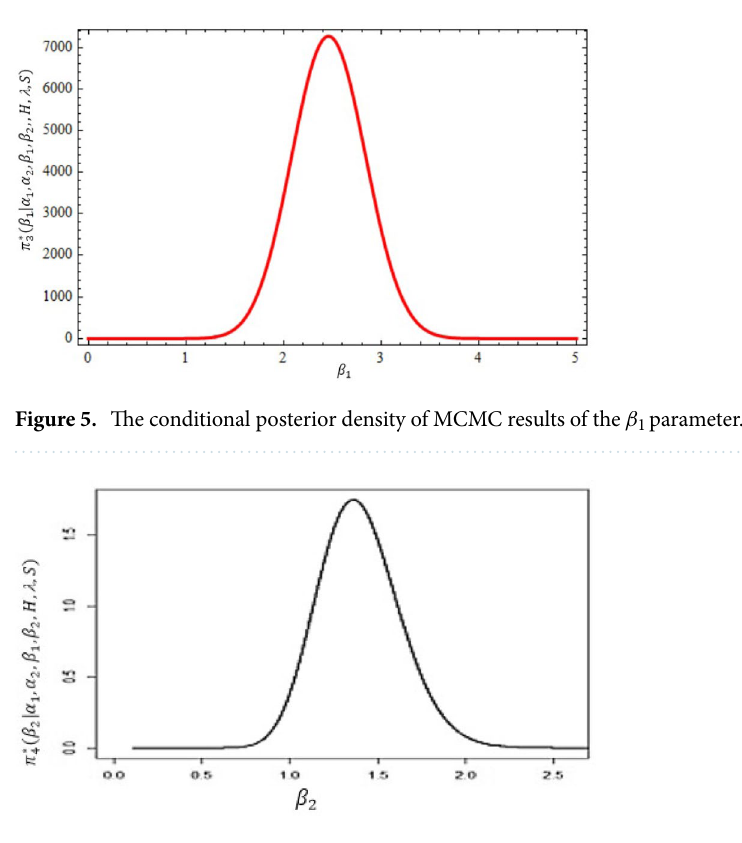
Figure 6. The conditional posterior density of MCMC results of the β 2